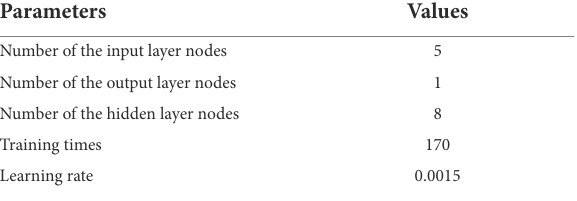
TABLE 1 Optimal parameters of long short-term memory